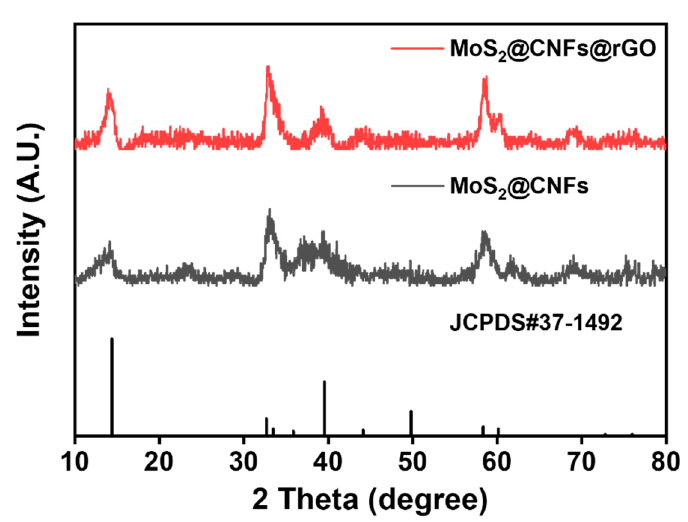
Figure 3. TEM images of ( a ) MoS 2 @CNFs and ( b ) MoS 2 @CNFs@rGO, ( c , d ) HR-TEM images of MoS 2 @CNFs@rGO, ( e ) STEM image and elemental distribution of C, Mo, and S in the MoS 2 @CNFs@rGO (scale bar: 20 nm).